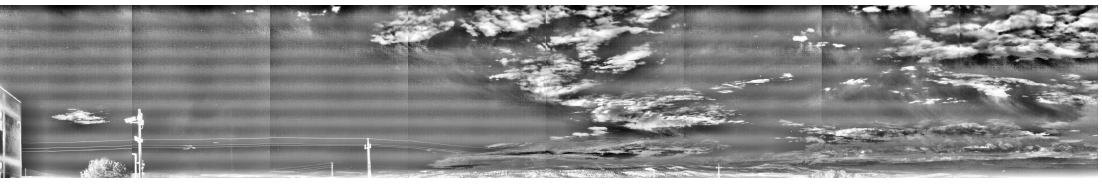
Figure 5. Thermal panoramic